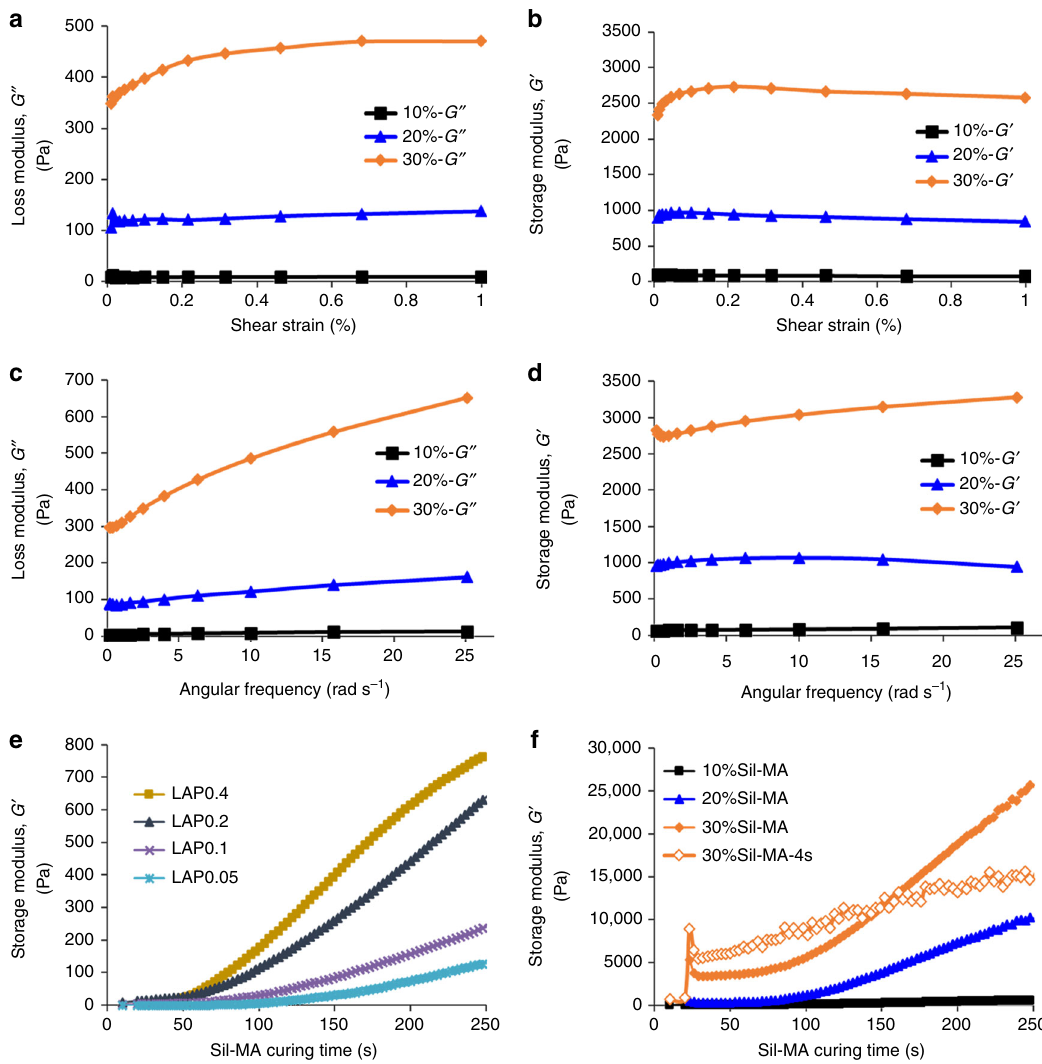
Fig. 4 Rheological analysis for Sil-MA hydrogel. a , b Strain dependency and c , d frequency dependency of a , c loss modulus ( G ″ ) and b , d storage modulus G ′ for Sil-MA hydrogels at different Sil-MA contents varied from 10 to 30%. e , f In situ rheology during UV exposure. The effect of e LAP contents and f Sil- MA contents on the G ′ during UV exposure for 250 s except for the line with orange squares (30%Sil-MA) exposed for only 4 s. The black line, blue line, and orange line indicate 10%, 20%, and 30% of Sil-MA hydrogel,